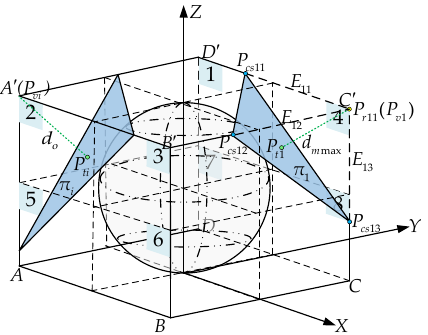
Figure 7. Diagram of constructing CP.